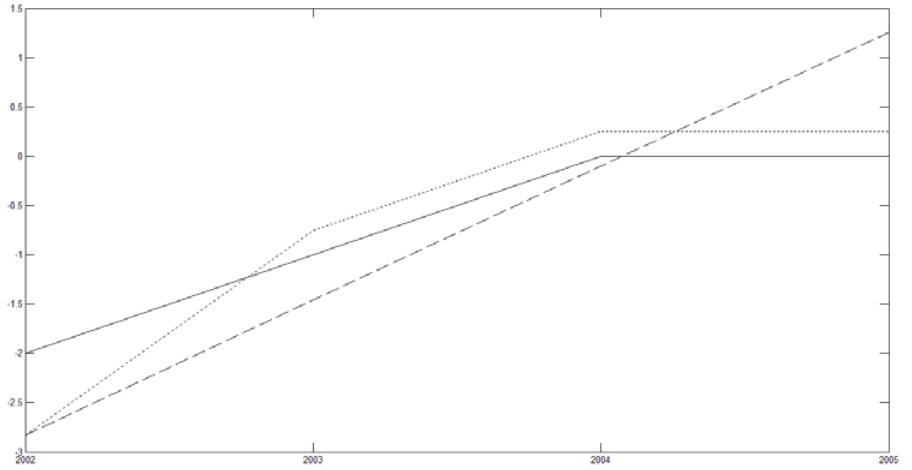
Figure 5. The constant slope and constant additive adjustments compared